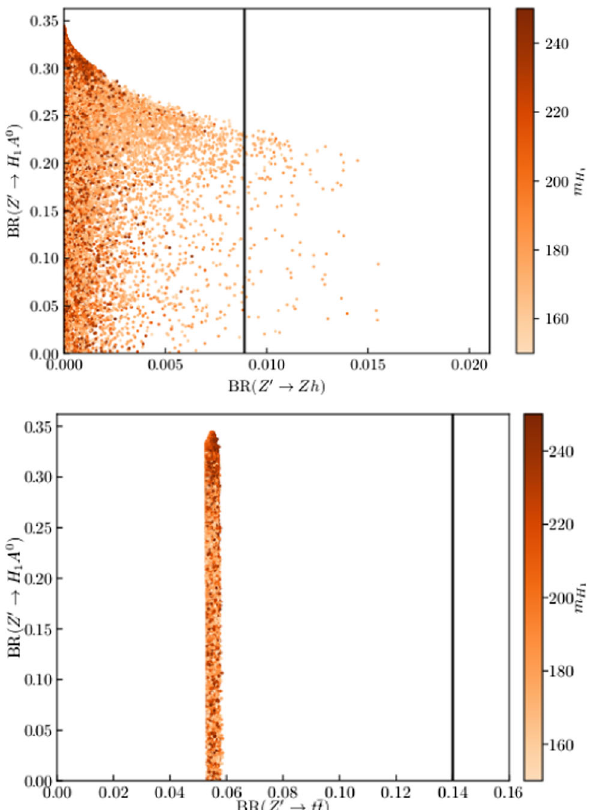
Fig. 6 Branching ratio for Z (cid:2) → H 1 A 0 versus Z (cid:2) → Zh (top) and Z (cid:2) → t ¯ t (bottom) resulting from the parameter space scan in scenario 3. The vertical lines correspond to the experimental upper bound. The colour grading is related to the m H value as shown on the right 2